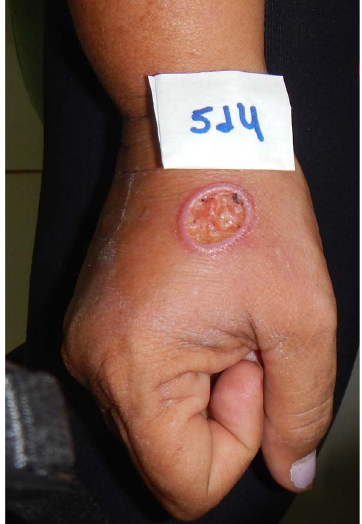
Figure 2. Single cutaneous Leishmaniasis lesion associated with Leishmania lindenbergi observed in a patient (Patient 2) from the State of Rondônia, Brazil. Clinical diagnosis was con fi rmed by direct and indirect parasitological tests (see Table 1 for details), and Leishmania species identi fi cation was achieved by Multilocus Enzyme Electrophoresis